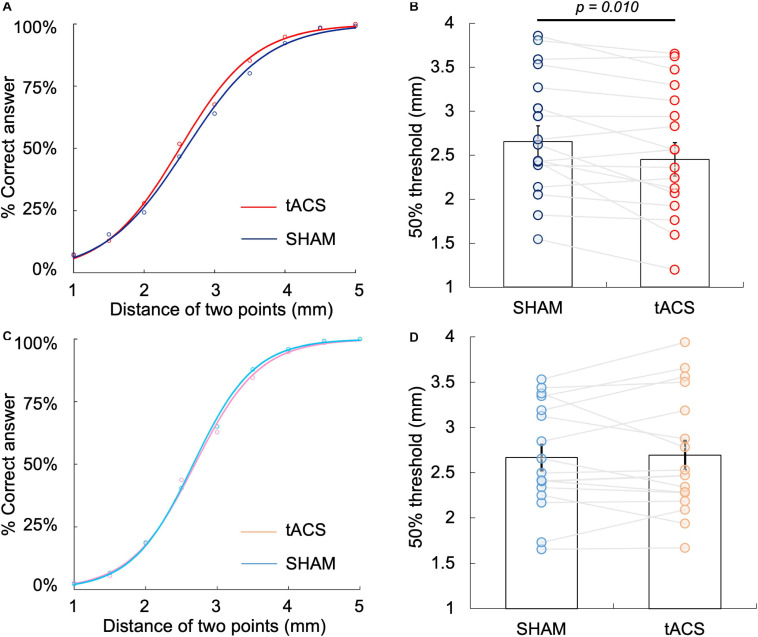
Differences in 50% TPD threshold between the tACS and sham conditions at the left PPC and left S1. (A) Psychophysical curve of the tACS and sham conditions at the left PPC in Experiment 1. (B) Comparison of 50% TPD threshold between the tACS and sham conditions in Experiment 1, where the X-axis indicates TPD threshold and Y-axis indicates the percentage of correct answers. The 50% TPD threshold in the tACS condition was significantly lower than that in the sham condition (P = 0.010). (C) Psychophysical curve of the tACS and sham conditions at the left S1 in Experiment 2. (D) Comparison of 50% TPD threshold between the tACS and sham conditions in Experiment 2, where the X-axis indicates TPD threshold and the Y-axis indicates the percentage of correct answers. There was no significant difference in 50% threshold between the tACS and sham conditions (P > 0.05).